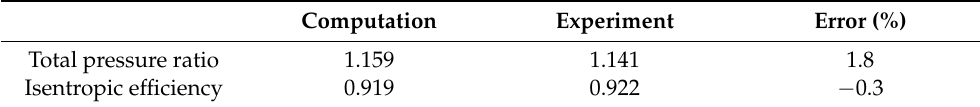
Table 2. Computed and experimental LSCC performance on design point.